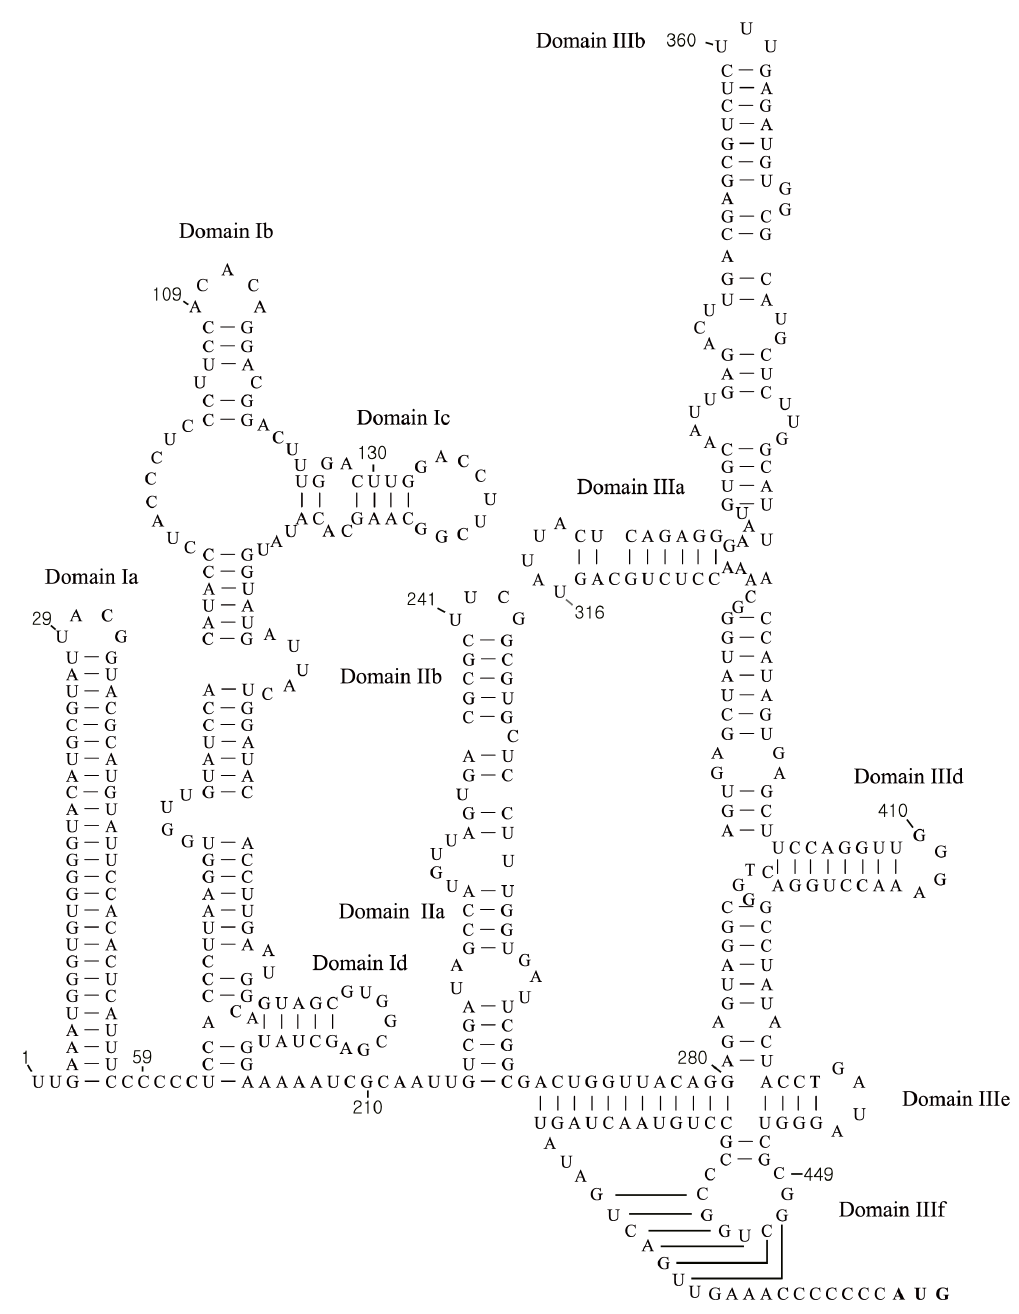
Figure 4. Sequences and structural features of 5 9 untranslated region of the porcine sapelovirus KS05151 strain. At the extreme 5 9 terminus are two stem-loop structures, labelled domains Ia and Ib. Secondary stem-loops include two smaller stem loop structures labelled Ic and Id. A secondary structure model for the domains II and III of the type IV internal ribosome entry site element is shown (this model is based on previously published studies [9,29,30]).